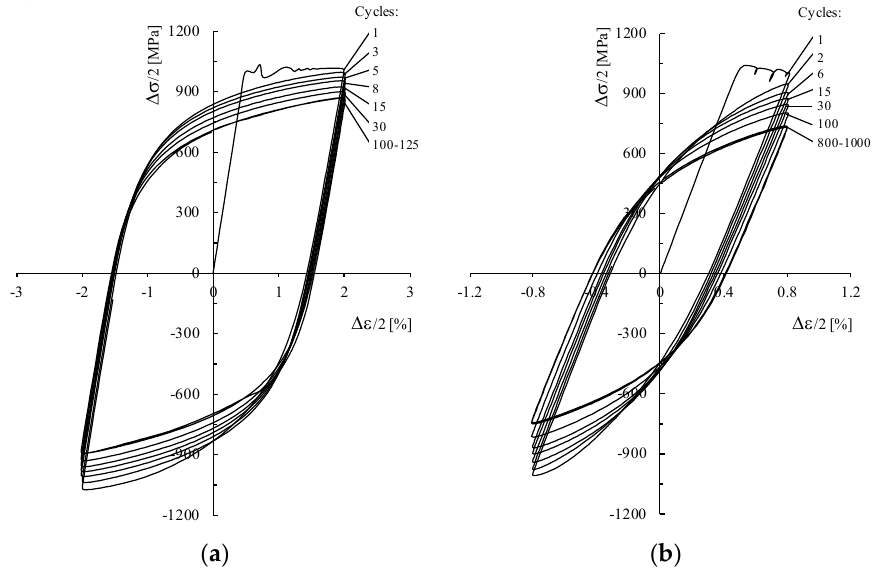
Figure 4. Stress ‐ strain hysteresis loops: ( a ) Δε /2 = ±2.0%; ( b ) Δε /2 = ±0.8%.